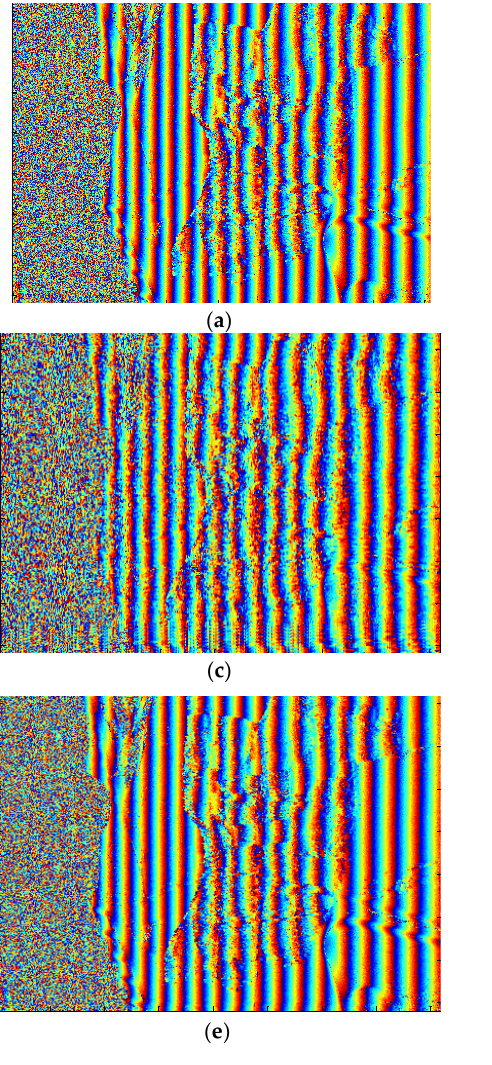
Figure 9. Estimation process of forest height in a pixel unit using real X−band PolInSAR data. Figure 9 shows the middle-process part of the estimation results obtained using the forest height estimation method proposed in this paper in a pixel resolution unit of the forest area. The blue points in the figure indicate the distribution range of the PolInCCs of the original image under different polarization states. It can be seen that the distribu- tion of the PolInCCs of this pixel point was relatively concentrated. Conventionally, the ground phase (black points in the figure) can be determined via straight-line fitting with these dots (blue points in the figure). The figure shows that the ground phase (after re- moving the flat effect) obtained via straight-line fitting (green straight line), estimated using only the PolInCC points of the original image, displayed a large error (−20.7°) compared with the actual ground phase (nearly 0°). However, the ground phase error obtained based on the expanded distribution range of the PolInCCs was small. By using the PolInCCs from the sub-view interferogram obtained by means of FS (purple points